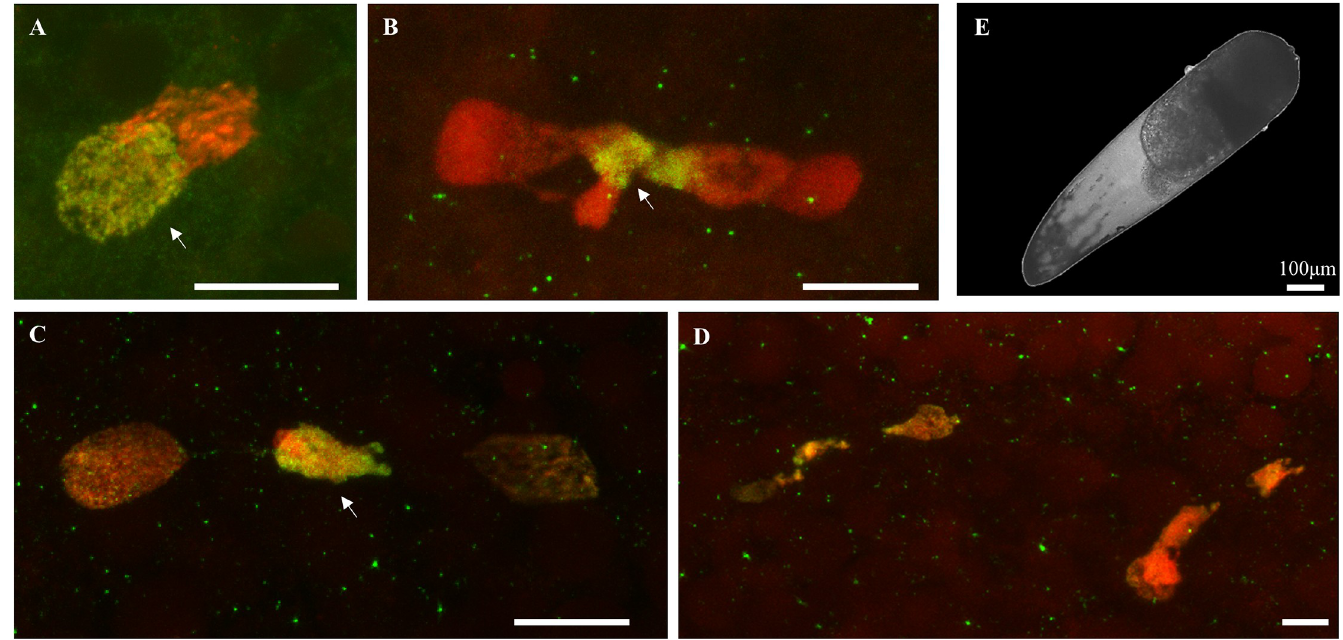
Fig 3. CI embryos from infected fathers and uninfected mothers: An arrest after the first nuclear divisions. Paternal chromatin appears in green/yellow (acetylated histone H4 labelling is dominant) and maternal chromatin appears in red (propidium iodide labelling is dominant) (A) apposition of maternal and paternal pronuclei, (B) paternal chromatin failed to segregate and form a chromatin bridge between segregated maternal chromatin, (C) two nuclei containing mainly maternal chromatin while paternal chromatin do not segregate, (D) abnormal development at 2 hours after oviposition: only few aborted divisions are observed, (E) none of the embryos from such crosses exhibited any visible development under microscope 48 hours post-oviposition. White arrows indicate the paternal chromatin. Confocal stacks (panels A,B,C,D,) and optical images (panels E) were obtained on embryos from several CI crosses between infected males and uninfected females due to the difficulty to obtain all the early embryonic stages for each cross (S2 Table). Green dots are background noises likely due to the presence of residual antibodies. Scale bar is 10 μ m.